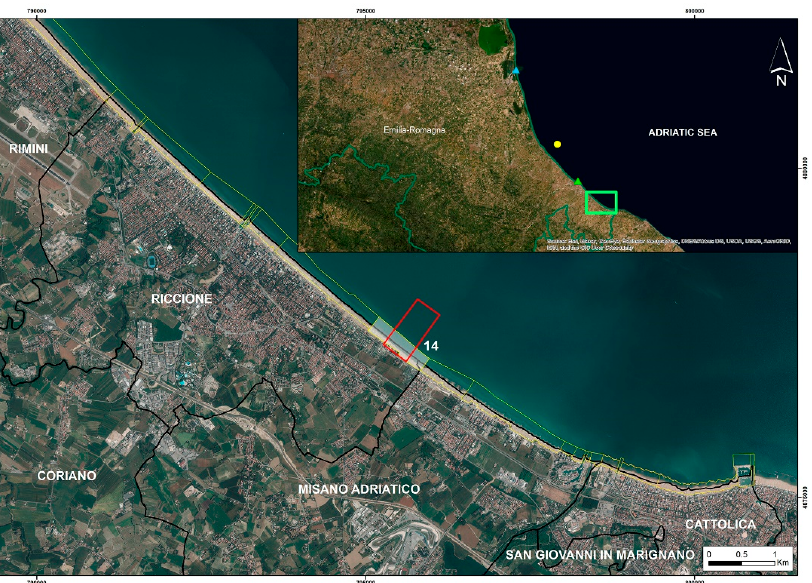
Figure 1. Location of the study area (red rectangle) in the southernmost Emilia-Romagna coastal area (see inset). Black lines indicate the limits of municipalities; yellow lines represent the subdivision of littoral cells according to [24]. The studied area is part of cell 14 (shaded area). In the inset, location of the tide gauge at Marina di Ravenna and of the Nausicaa buoy at Cesenatico are indicated by a blue triangle and by a yellow dot, respectively. Orthophotograph is obtained from Agea 2011, while the image in the inset is derived from ESRI.